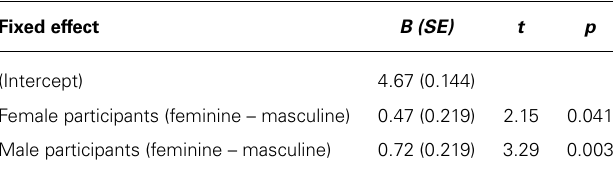
Table 2 | Fixed effect estimates for a rating bias toward feminine morphed faces in Experiment 1.